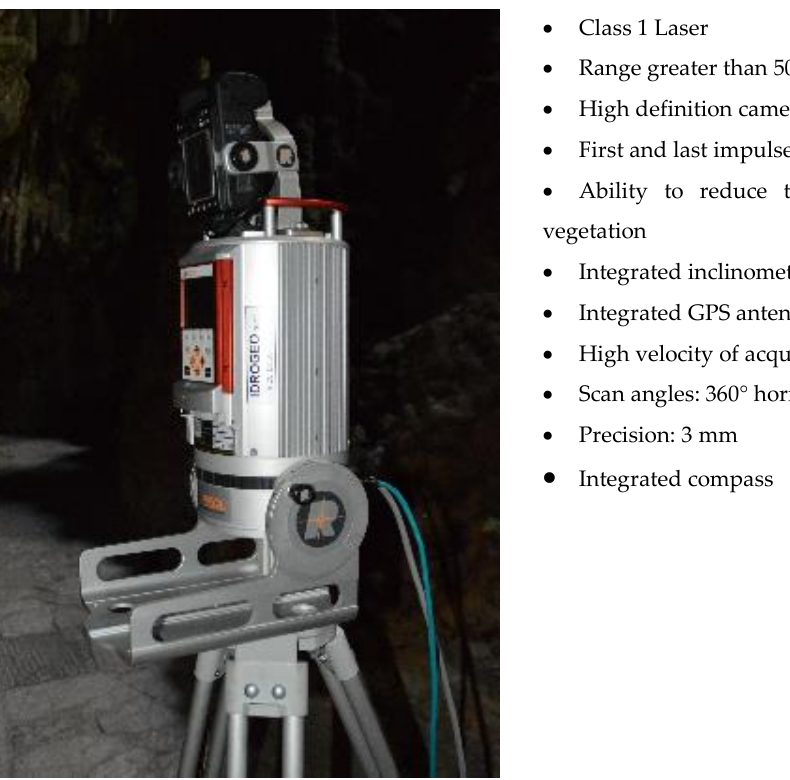
Figure 1. Main characteristics of the Laser Scanner Riegl VZ400.